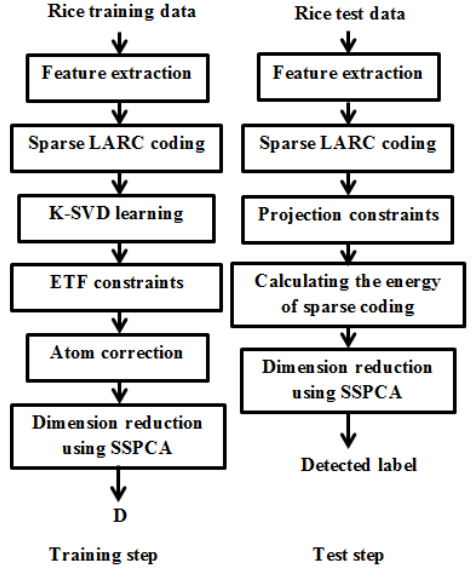
Figure 3. Block diagram of the proposed rice classification method based on the learned incoherent models and the dimension reduction